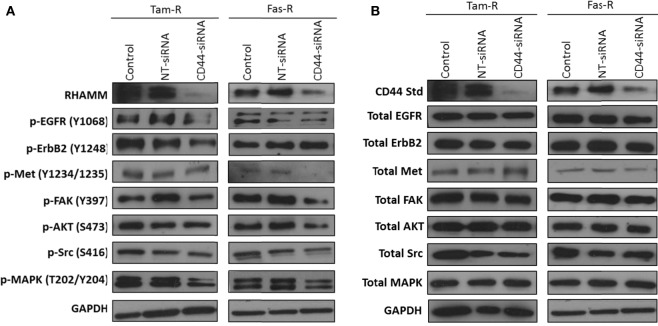
Inhibition of CD44 expression suppresses endogenous growth factor pathway activity in Tam-R and Fas-R cells. Western blotting analysis was used to determine the effects of CD44 suppression on signaling activity in Tam-R and Fas-R cells. (A) CD44 suppression reduced EGFR, ErbB2, and MAPK phosphorylation in Tam-R cells and reduced Met, AKT, and MAPK phosphorylation in Fas-R cells. (B) No change in total protein levels was observed.